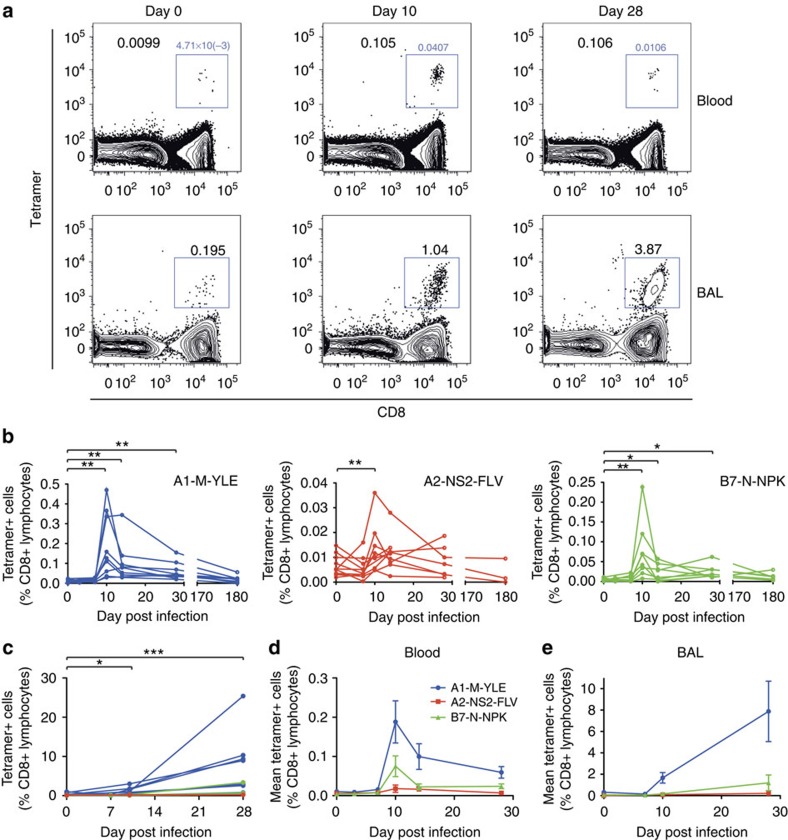
RSV antigen-specific CD8+ T-cell kinetics diverge in BAL compared with blood.Whole blood/PBMCs and BAL from RSV-infected individuals were co-stained with anti-CD3, CD8 and tetramers, and then analysed by flow cytometry. (a) Numbers represent the percentage of A1-M-YLE+ CD8+ T cells as a proportion of CD3+ lymphocytes at day 0, 7, 10, 14 and 28 post inoculation. Representative plots for one subject gated on CD3+ lymphocytes are shown. (b) The frequencies of A1-M-YLE (n=9), A2-NS2-FLV (n=10) and B7-N-NPK (n=8) tetramer-positive cells in blood as a proportion of CD8+ T cells are shown up to 6 months follow-up. P values for Wilcoxon matched pairs tests compared with day 0 are shown (A1-M-YLE day 10, P=0.0039; day 14, P=0.0039; day 28, P=0.0039; A2-NS2-FLV day 10, P=0.0488; B7-N-NPK day 10, P=0.0078; day 14, P=0.0223; and day 28, P=0.0207). (c) The frequencies of A1-YLE, A2-NS2-FLV and B7-N-NPK tetramer-positive cells in BAL as a proportion of CD8+ T cells are shown. P values for Wilcoxon matched pairs tests are shown comparing day 10 (P=0.0156) and day 28 (P=0.0002) frequencies with baseline. Abbreviated P values are shown: NS (not significant)=P>0.05, *P<0.05, **P<0.01. Mean±s.e.m. of epitope-specific CD8+ T-cell responses are shown in (d) blood (n=20) and (e) BAL (n=13).